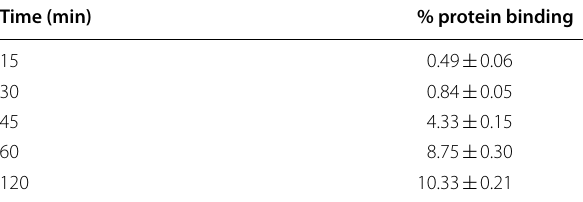
Table 4 Protein binding of [ 68 Ga]Ga‑4HMSA in rodent plasma Time (min) % protein